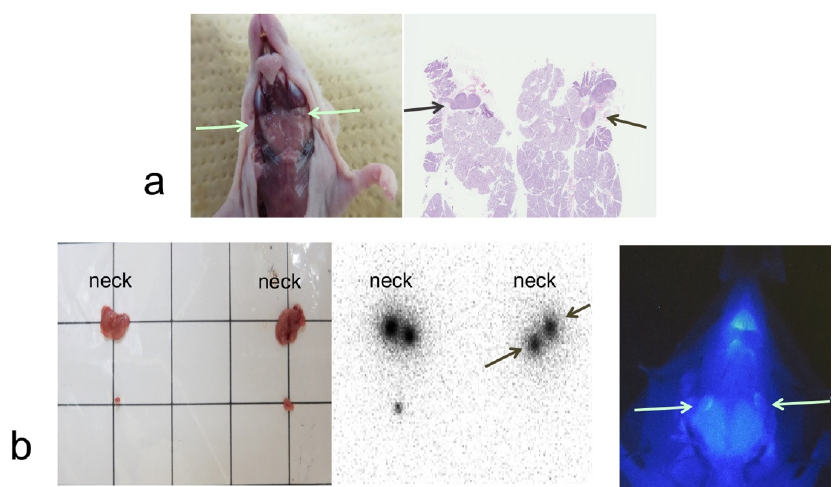
Figure 2. Neck lymph node in normal mouse ( a ). The arrows indicate neck lymph nodes in dissection. H&E staining showed lymph nodes in the excised cervical tissue ( a ). Two-phase combined imaging of SLNs in normal mice ( b ). 99m Tc-Phytate and anti-EGFR affibody probe were injected into the tongue of mice. Two excised neck specimens with lymph nodes from two mice are shown ( b , left). Autoradiography showed that 99m Tc radioactivity accumulated in the lymph nodes of each neck specimen and one solitary lymph node in the corresponding tissues of the left panel ( b , middle). NIR fluorescence was localized in the lymph nodes after anti-EGFR affibody probe injection into the tongue ( b , right).